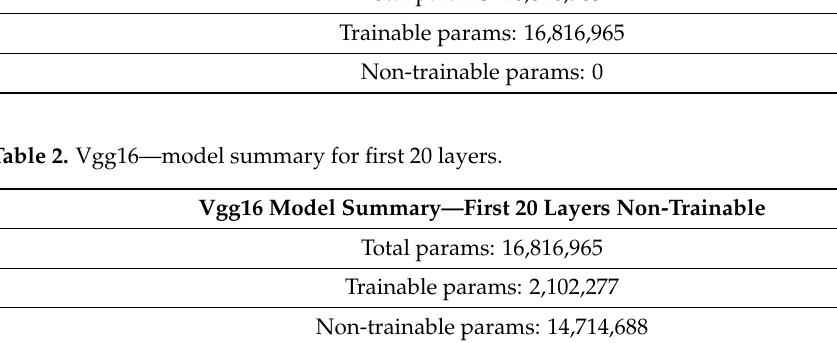
Figure 3. Drawing with Keras augmentation.